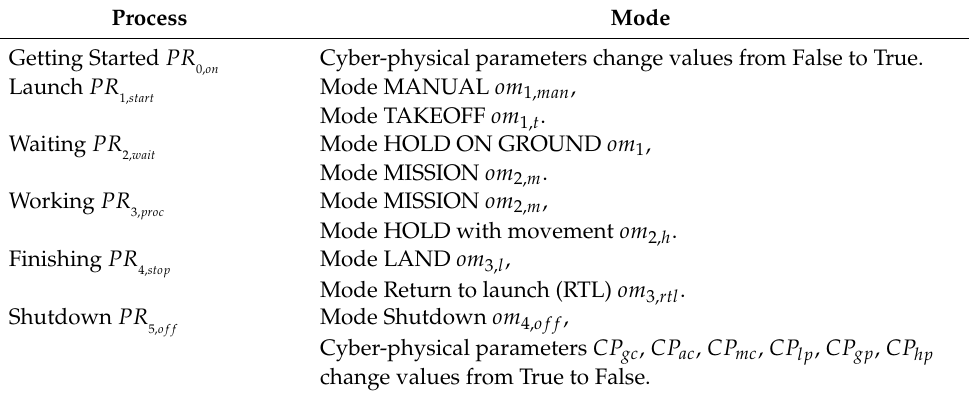
Table 1. Comparison of UAV processes and